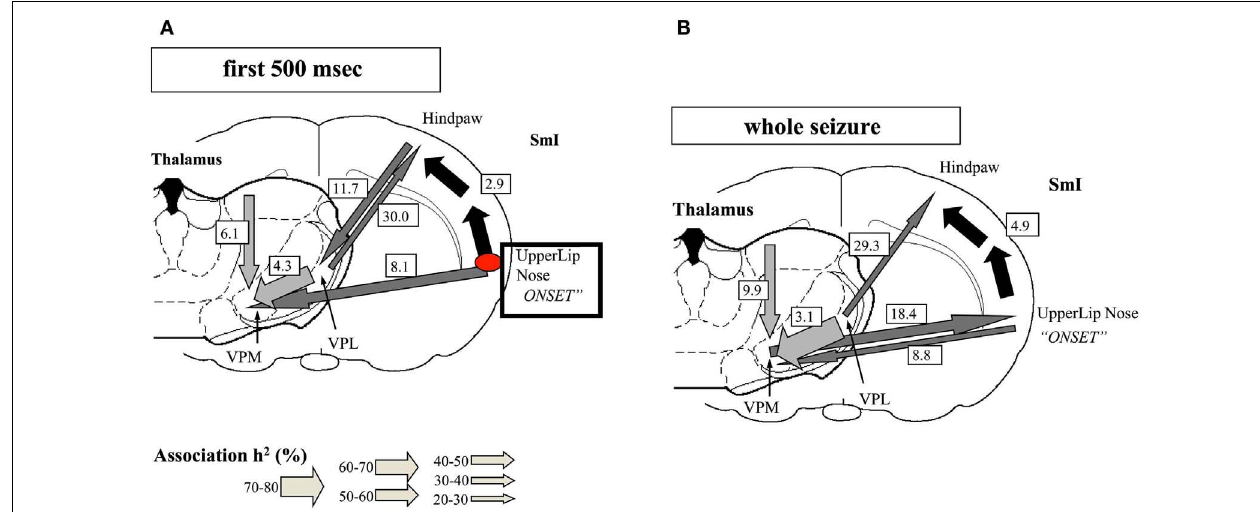
consistently lead other thalamic sites.The ventroposterior medial (VPM) nucleus was found to lag behind the ventroposterior lateral (VPL) nucleus, with an average time delay of 4.3ms. Concerning cortico-thalamic interrelationships, the cortical focus site consistently led the thalamus (VPM), with an average time delay of 8.1ms. (B) The relationships found when the whole seizure is analyzed as one epoch. The same cortical focus as during the first 500ms was found consistently. Compared with the first 500ms, the time delay from the cortical focus with respect to the non-focal cortical sites increased. Furthermore, the strength of association betweenVPL andVPM also increased.The direction of the cortico-thalamic couplings changed. For the non-focal cortical sites, the thalamus was found to lead during all seizures. For the focal cortical site, the cortex was found to lead during two seizures, whereas the thalamus was found to lead during seven seizures (Meeren et al.,